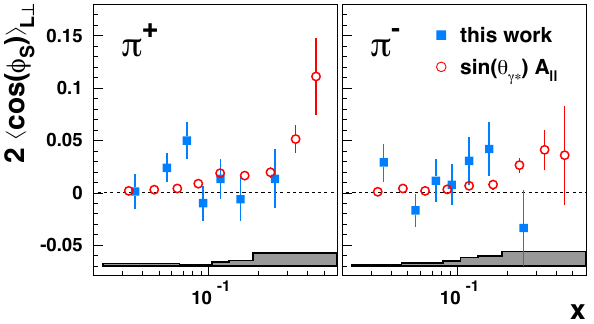
Figure 40 . The x dependences of the charged-pion 2 h cos( φ S ) i (blue squares) and the contribution to this observable from A HERMES measurement [175], which is taken in the range 0 . 2 < z < 0 . 8 , is scaled by the average sin θ γ ∗ in each